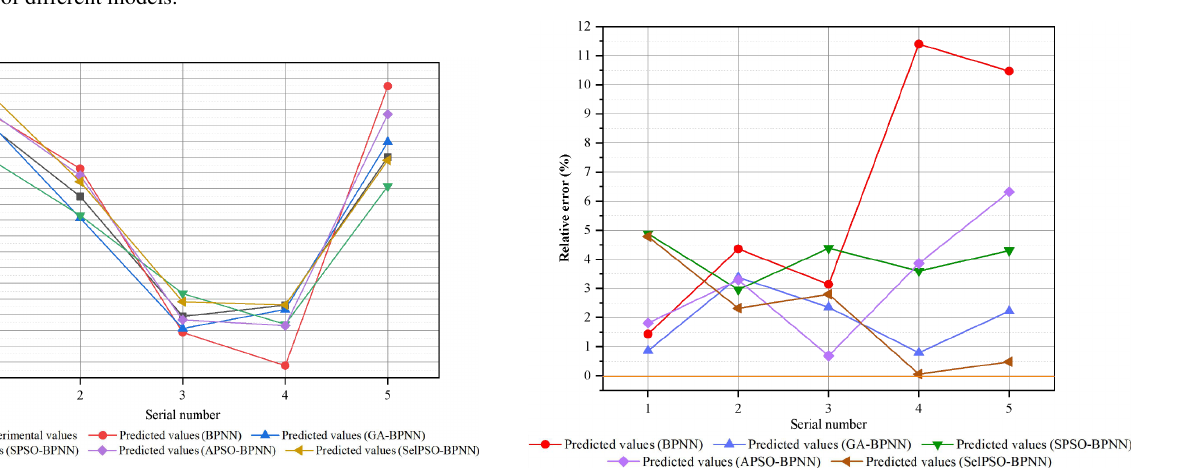
Figure 11. Comparison of the prediction results of different mod- els.